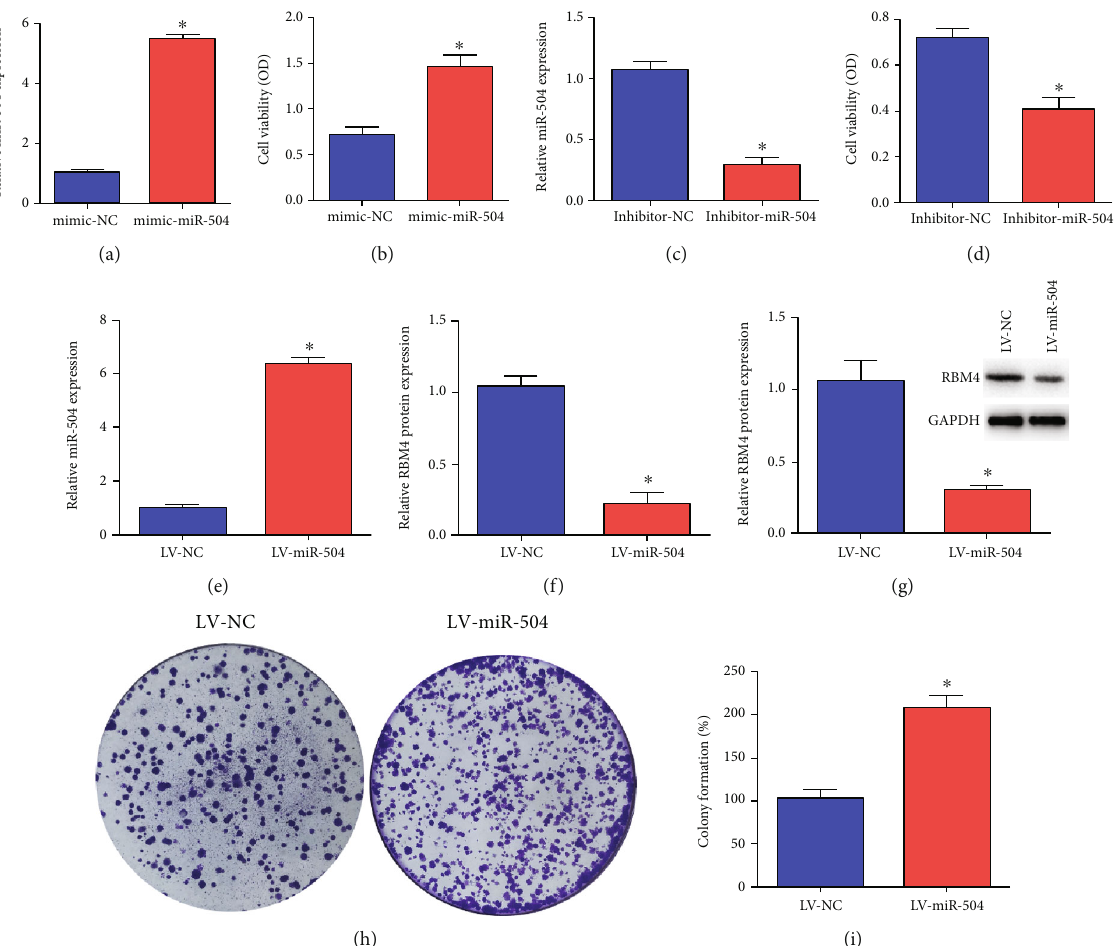
Figure 2: miR-504 increased the viability of gastric cancer cells. (a) Relative expression of miR-504 mRNA in SGC-7901 cells in the mimic- NC group and mimic-miR-504 group. (b) The cell viability of SGC-7901 cells in the mimic-NC group and mimic-miR-504 group. (c) Relative expression of miR-504 mRNA in SGC-7901 cells in the inhibitor-NC group and inhibitor-miR-504 group. (d) The cell viability of SGC-7901 cells in the inhibitor-NC group and inhibitor-miR-504 group. (e) Relative expression of miR-504 mRNA in the LV-NC group and LV-miR- 504 group. (f, g) The expression of RBM4 mRNA and protein in the LV-NC group and LV-miR-504 group. (h, i) Colony formation of SGC- 7901 cells in the LV-NC group and LV-miR-504 group. ∗ P < 0 : 05